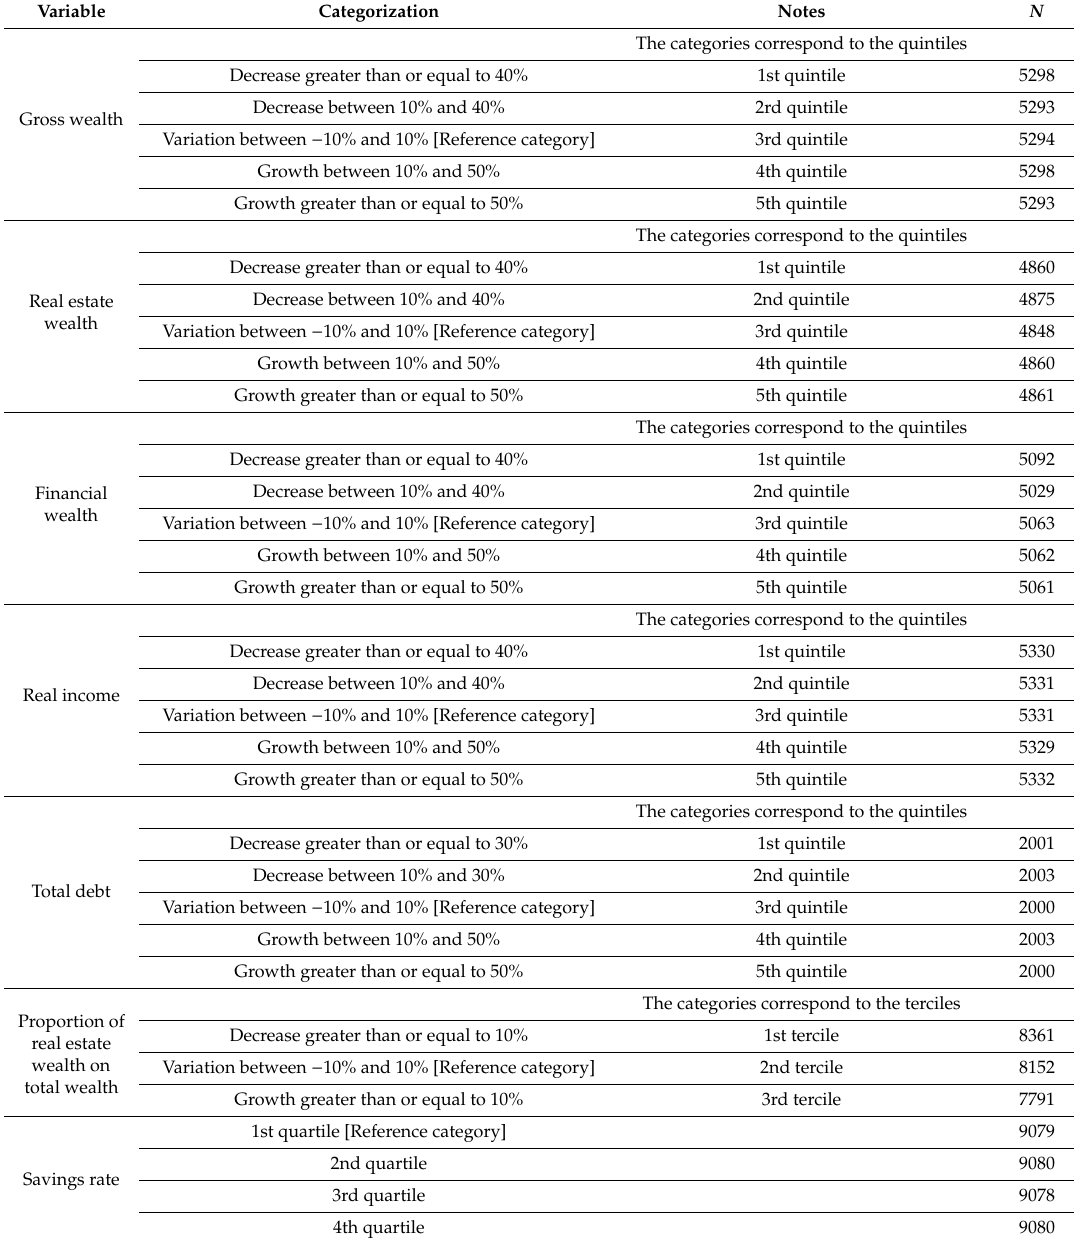
Table 1. Categorization of the